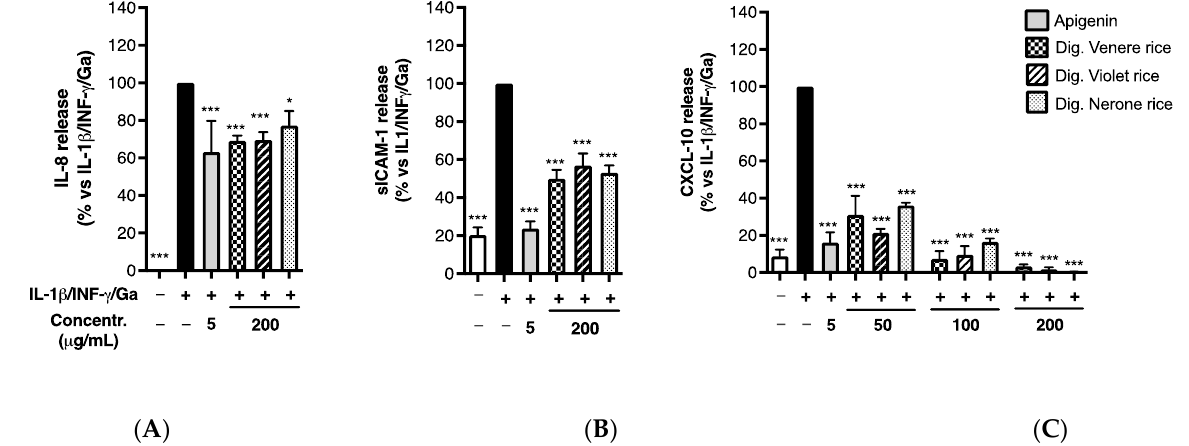
Figure 6. Effect of black rice extracts on IL-8 ( A ), sICAM-1 ( B ), and CXCL-10 release ( C ) after in vitro simulated digestion. Caco-2 cells were stimulated by IL- 1β (10 ng/mL), IFN - γ (10 ng/mL), and in vitro digested gliadin (Ga) (1 mg/mL) for 6 h. Unstimulated condition was also reported (white bar, Control − ). The release of inflammatory mediators in cell culture media was measured by ELISA assay and expressed as mean of release (% ± SEM) vs. stimulus (black bar, Control +). To the stimulus was arbitrarily attributed the value of 100%. * p < 0.05, *** p < 0.001 vs. stimulus.